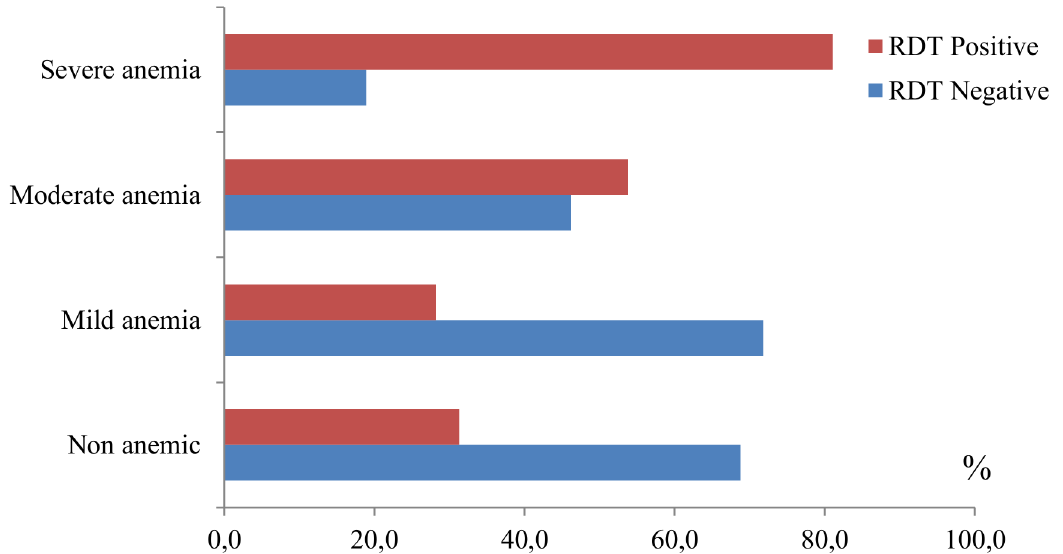
Fig 2. Distribution of malaria by anemia severity in children, Bata district, June-August 2013. RDT: Rapid diagnostictest.